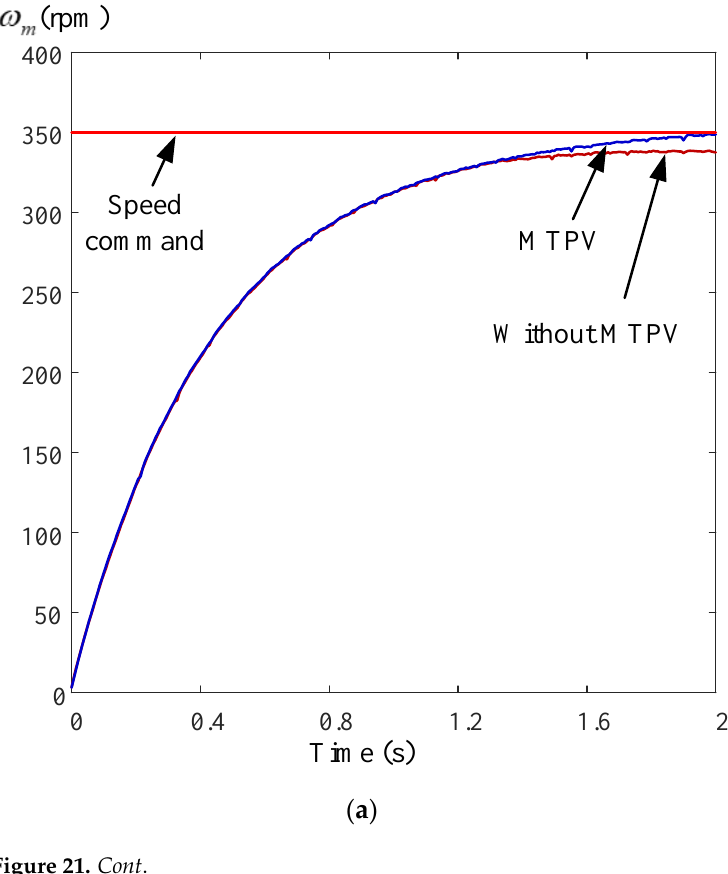
Figure 20. Measured responses at 300 r/min with flux-weakening control. ( a ) speeds, ( b ) currents.